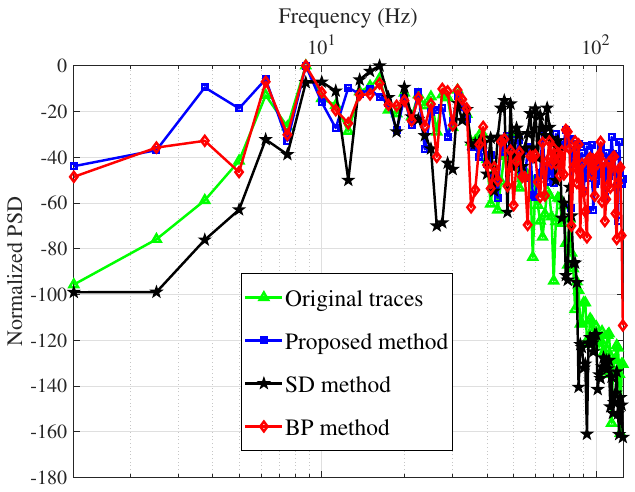
Figure 13. Normalized PSD of the original field traces, original reflectivity, and estimated